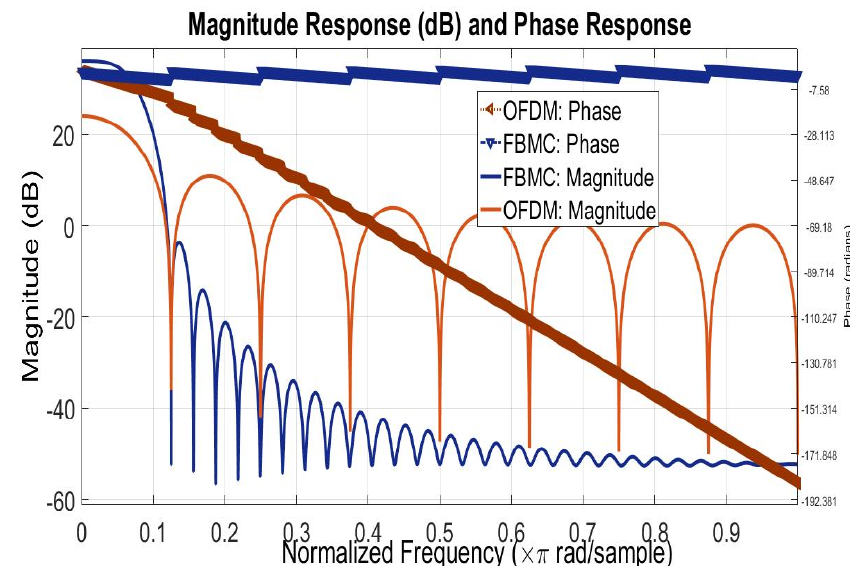
Figure 5. amplitude and phase characteristics. Figure 5. Amplitude and phase